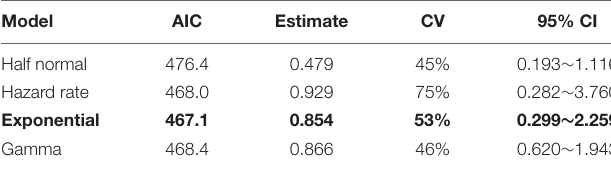
TABLE 5 | Estimate, coefficient of variation (CV) and 95% confidence interval (95% CI) of the density of dolphins (individuals per square kilometer, sighting data of both bottlenose and humpback dolphins from the two surveys are combined) using distance estimation methods with four density function models.